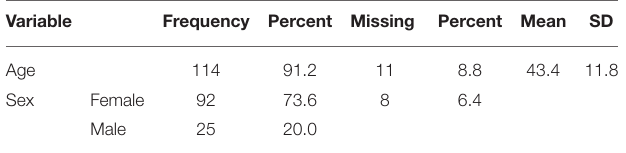
TABLE 2 | Participants characteristics ( N =